Question: Author a descriptive caption for the visualization shown.
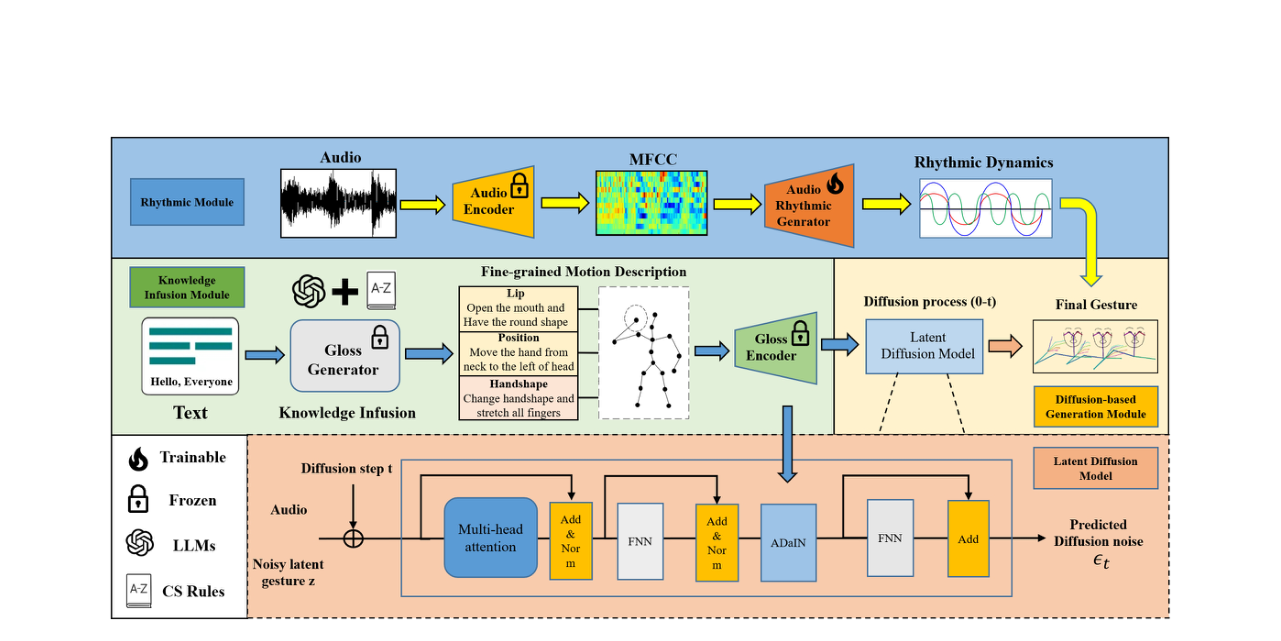
Answer: The overall framework of the proposed GlossDiff, where (a), (b), (c) represent the Knowledge Infusion Module, Audio Rhythmic Module and Diffusion-based generation module, respectively.